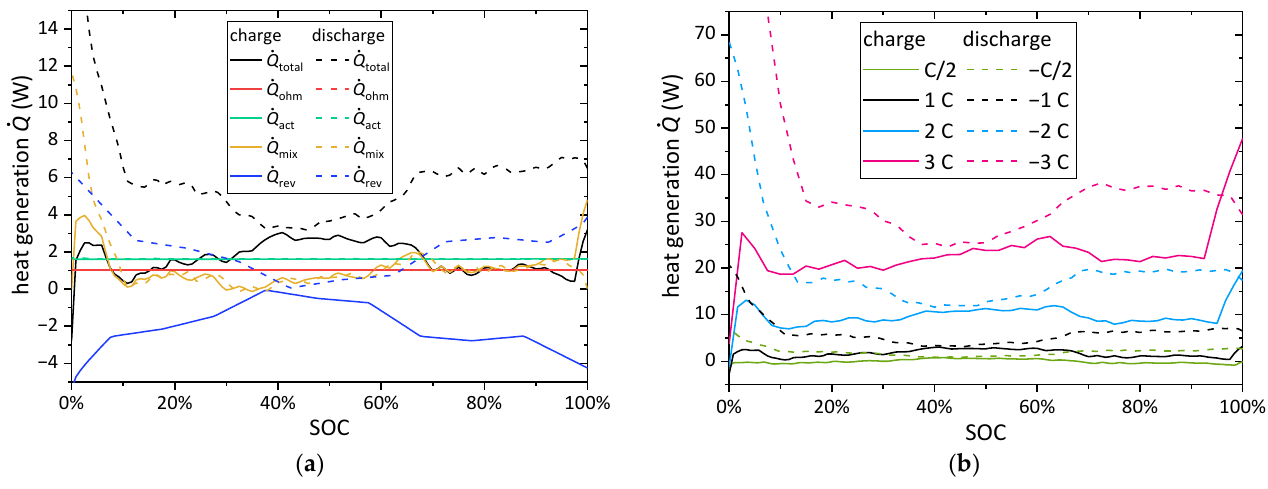
Figure 7. Heat generation of a pouch cell calculated with the lumped battery model as a function of the SOC. ( a ) Single contributions to the heat power for charging (solid lines) and discharging (dashed lines) with 1 C. ( b ) Total heat generation for different C-rates for charging and discharging.